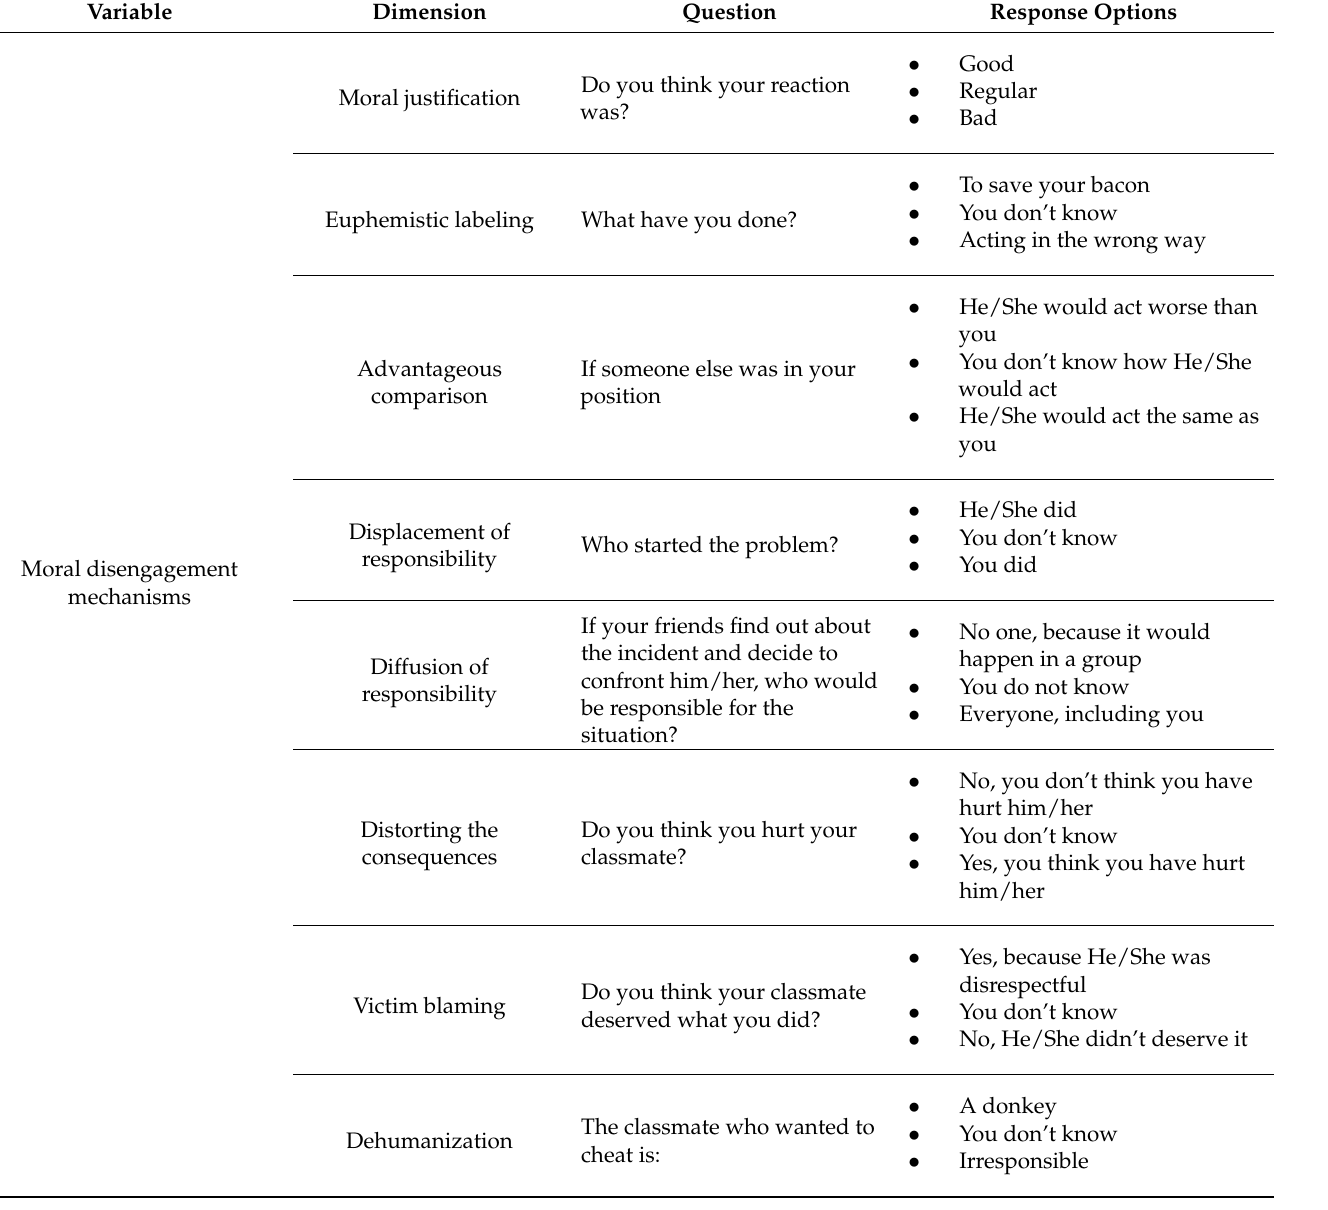
Table 5. Nominal variables to evaluate moral disengagement mechanisms (Bandura) and violence legitimation from peers and adults. Variable